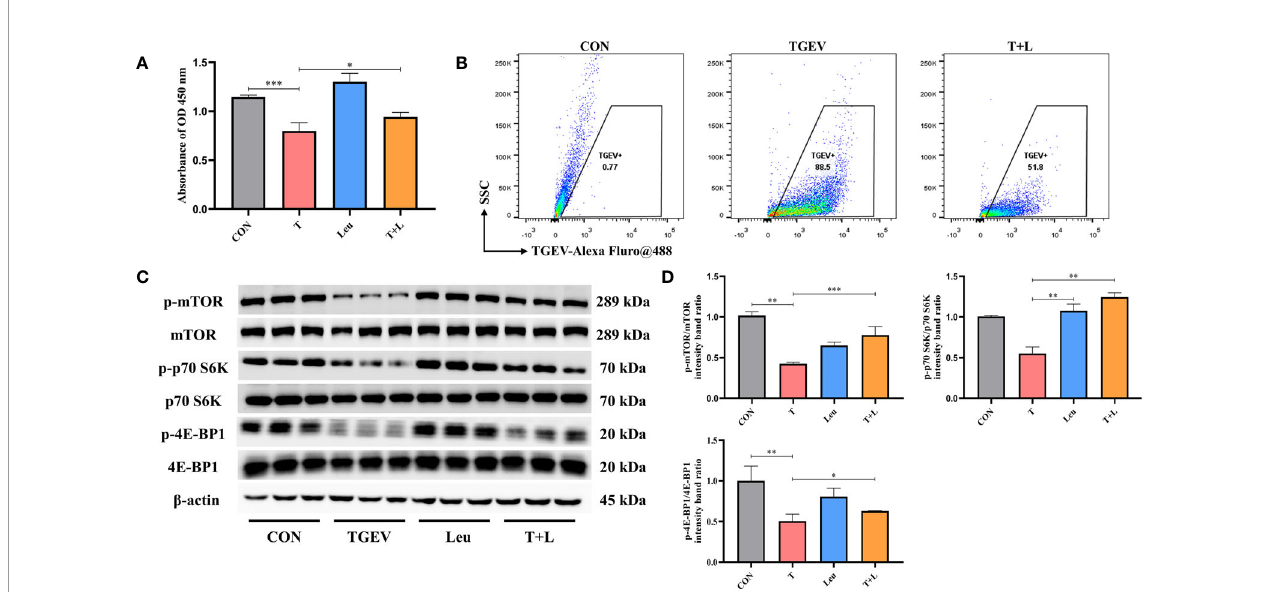
FIGURE 7 | TGEV replication was regulated by Leu treatment. (A) CCK-8 assay was used to detect the proliferation of IPEC-J2 cells pretreated with 10 mM Leu, followed by TGEV infection. Data express the mean ± SEM (n = 3). (B) The contents of TGEV were analyzed via fl ow cytometry in the IPEC-J2 cells pretreated with 10 mM Leu, followed by TGEV infection. (C) The protein levels of p-mTOR, mTOR, p-p70 S6K, p70 S6K, p-4E-BP1 and 4E-BP-1 were detected by western blot. (D) Quantitation of bands to demonstrate the protein level of p-mTOR/mTOR, p-p70 S6K/p70 S6K and p-4E-BP1. Data express the means ± SEMs (n = 3). The symbol * indicates statistically signi fi cant differences ( P < 0.05), ** P < 0.01 and *** P <